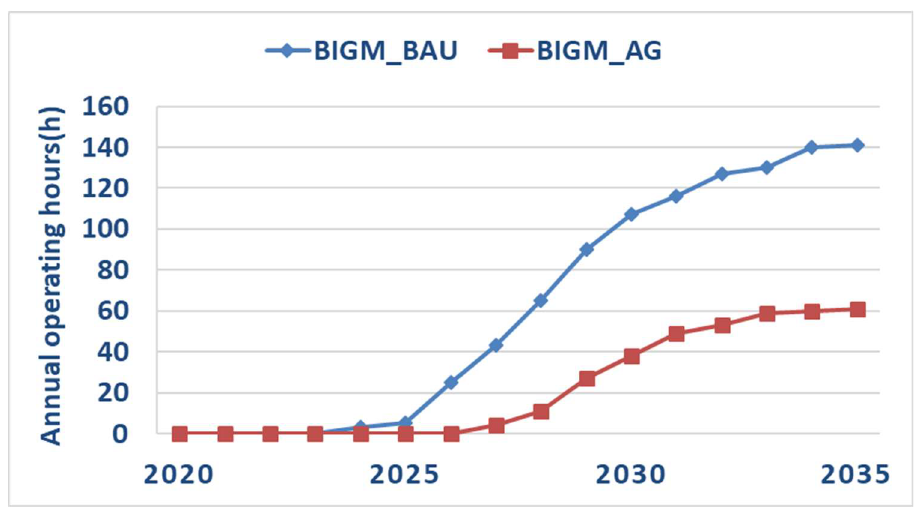
Figure 7. Comparison of the annual operating hours of BIGM under the BAU and AG reserve capacity adjustment scenarios.